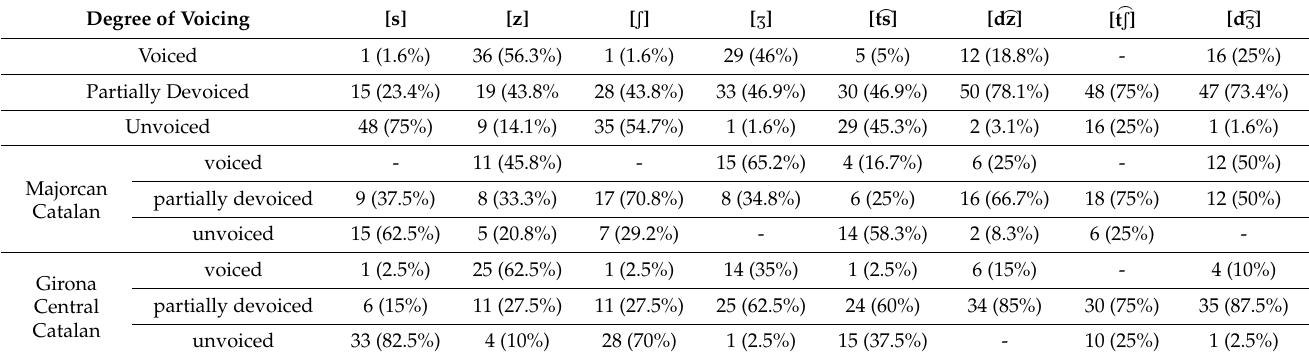
Table 6. Number of instances and percentage of occurrence of the three variants determined by Smith (1997) for each sibilant